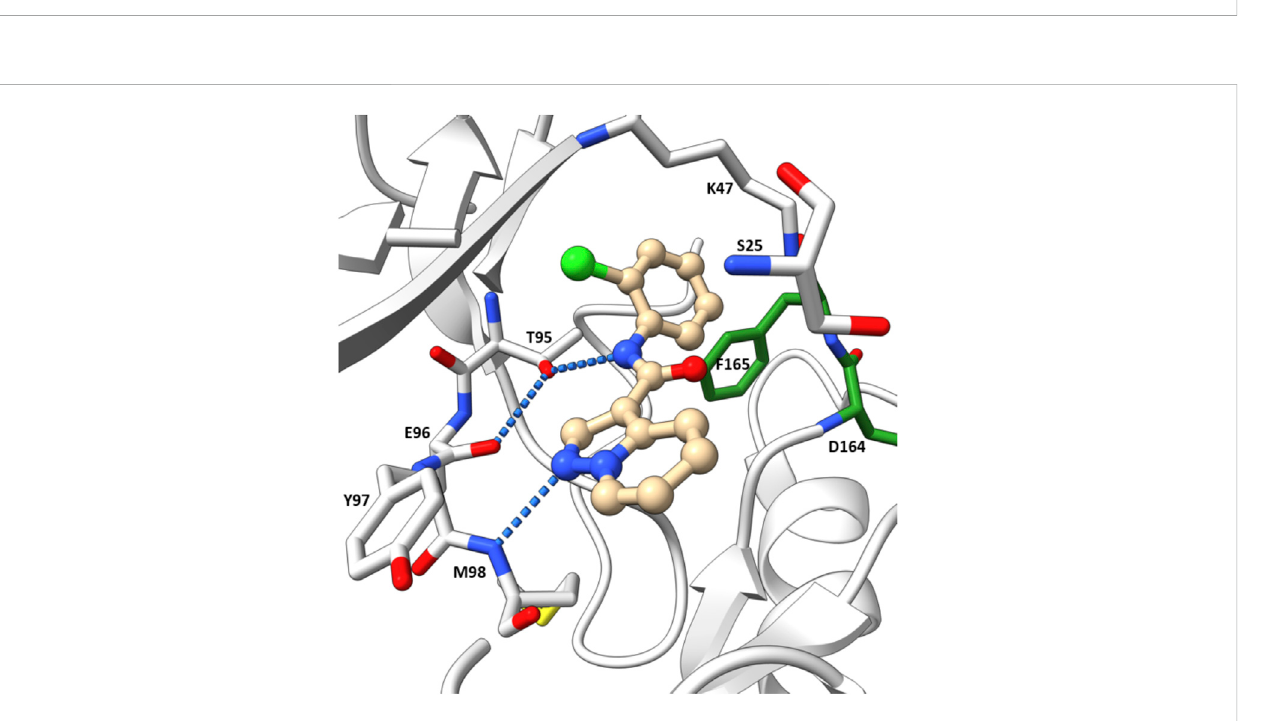
Co-crystal structure of 7 and RIPK2(PDB ID: